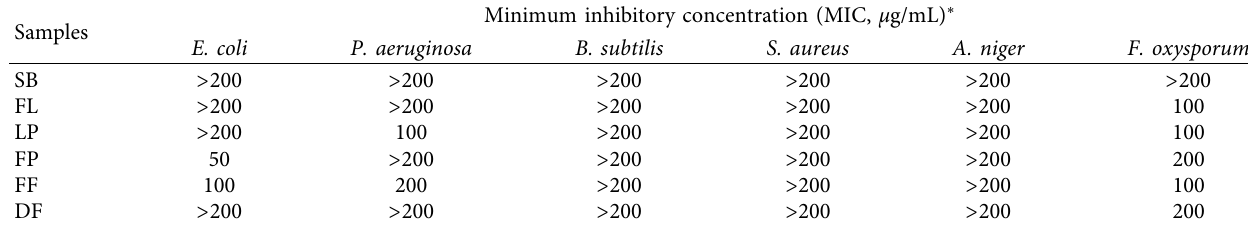
Table 3: Antimicrobial activities of essential